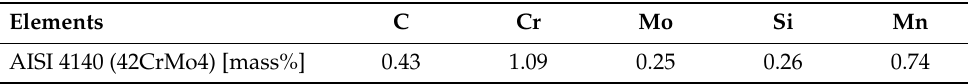
Table 1. Element concentration of the used AISI 4140 melt.